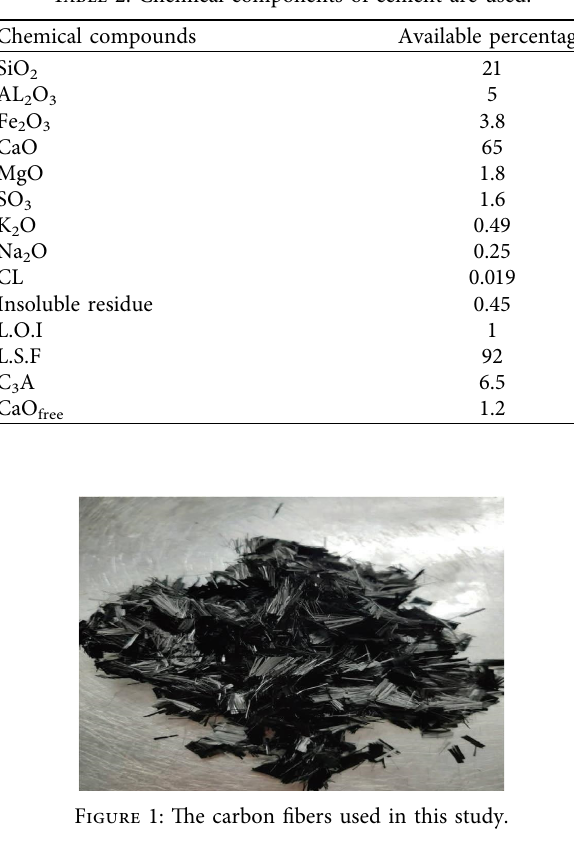
Table 2: Chemical components of cement are used.